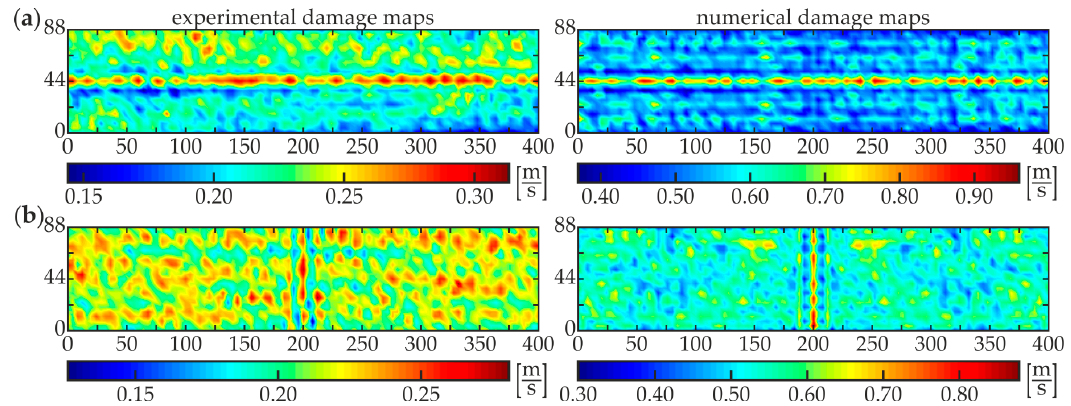
Figure 9. Experimental and numerical WRMS damage maps for specimen #1: ( a ) Excitation P3 and ( b ) Excitation P4.